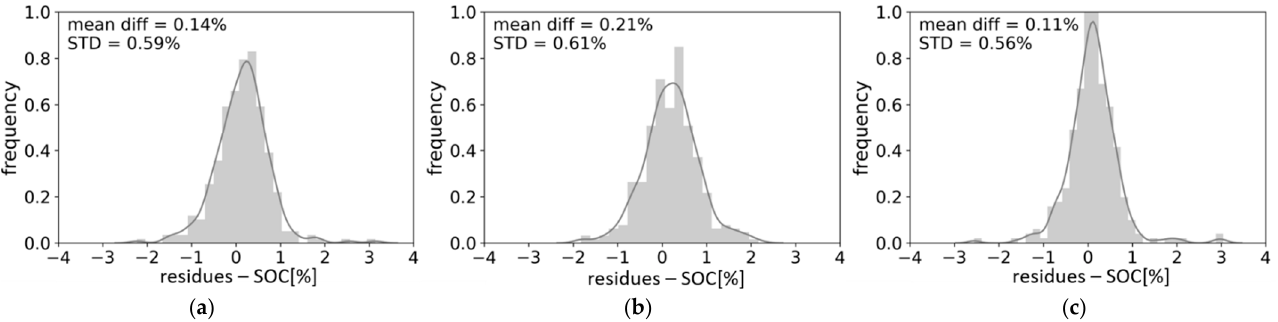
Figure 9. A comparison of the differences between the 308 predicted and the measured SOC contents of the external validation dataset using the best set of input data for ( a ) MLR, ( b ) PLSR and ( c ) RF.